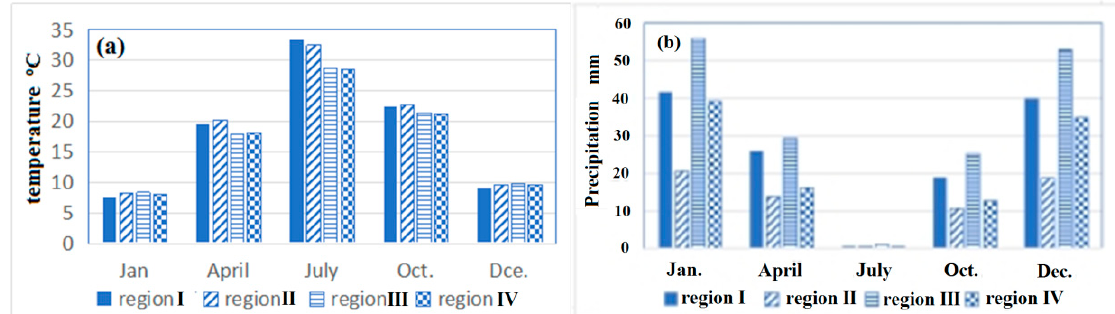
Figure 3. Surface temperature and precipitation in the four regions of Syria for 1979–2016. ( a ) Temperature, (unit: °C); and ( b ) precipitation (unit: mm).